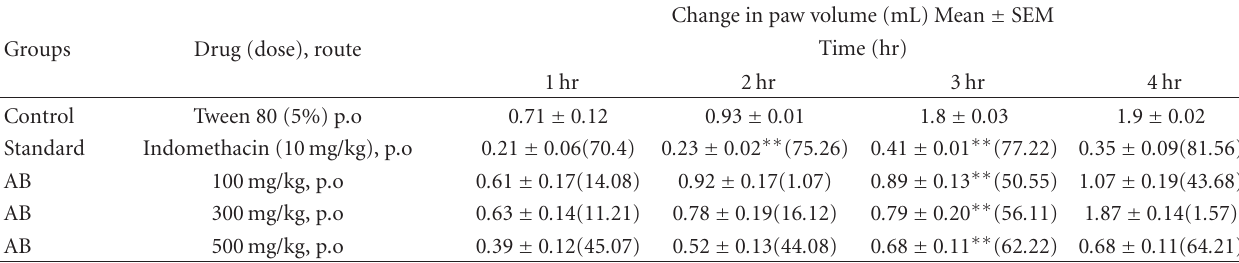
Table 1: Protective efeect of Pinus roxburghii Sarg. on paw edema induced by carrageenan in rat. Change in paw volume (mL) Mean ± SEM